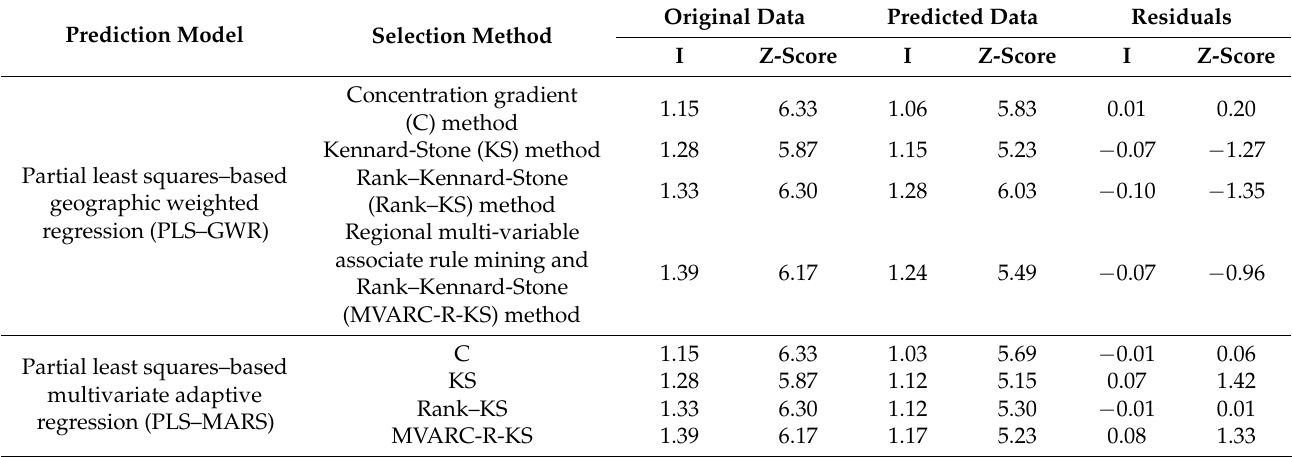
Table 1. Moran’s I index and z-score of data related with prediction models calibrated by different calibration set selec- tion methods. Prediction